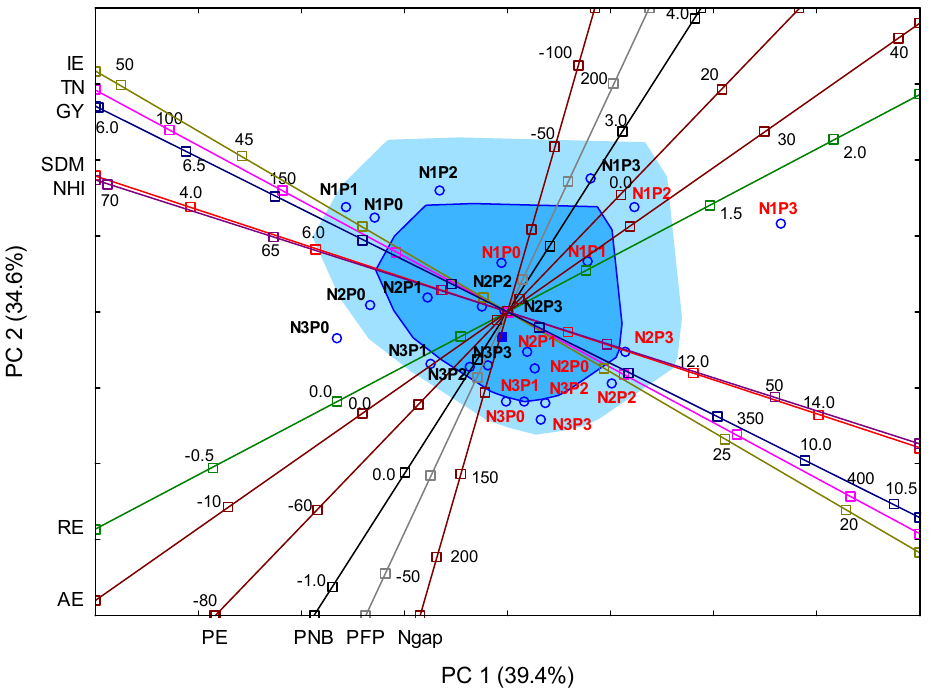
Figure 2. Principal component analysis (PCA) biplot of the maize yield and N use efficiency indices. The dark blue square denotes the Tukey median, the blue square is the bagplot, the light blue square is the bagplot cover. Key: GY—grain yield; SDM—crop residues (straw) biomass; TN—total N accumulation; NHI—N harvest index; PFP—partial factor productivity of N; AE—agronomic efficiency of N; PNB—partial N balance; RE—apparent N recovery efficiency; IE—internal N utilization efficiency; N gap —N gap. The treatments in 2019 are marked in red and the treatments in 2020 in